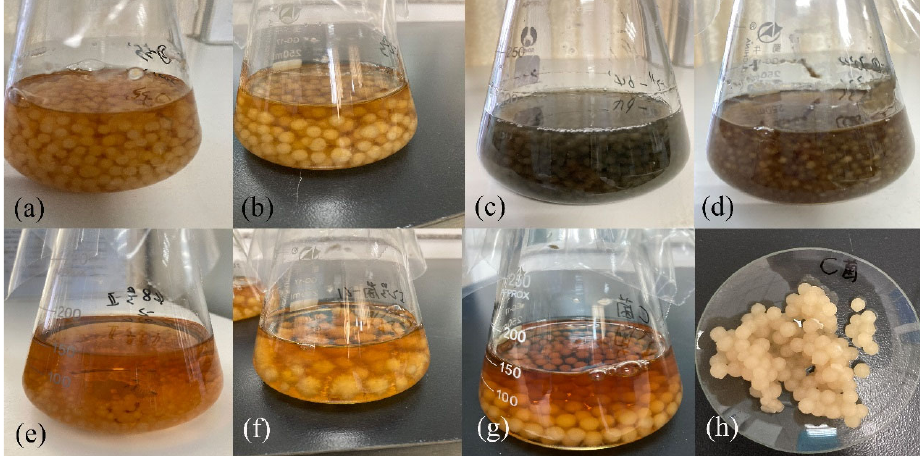
Figure 5. The mycelial morphology of strain in liquid medium. (( a ) was mutant 55, ( b ) was mutant 63, ( c ) was mutant 64, ( d ) was mutant 70, ( e ) was mutant 2, ( f ) was mutant 61, ( g , h ) were original strains).